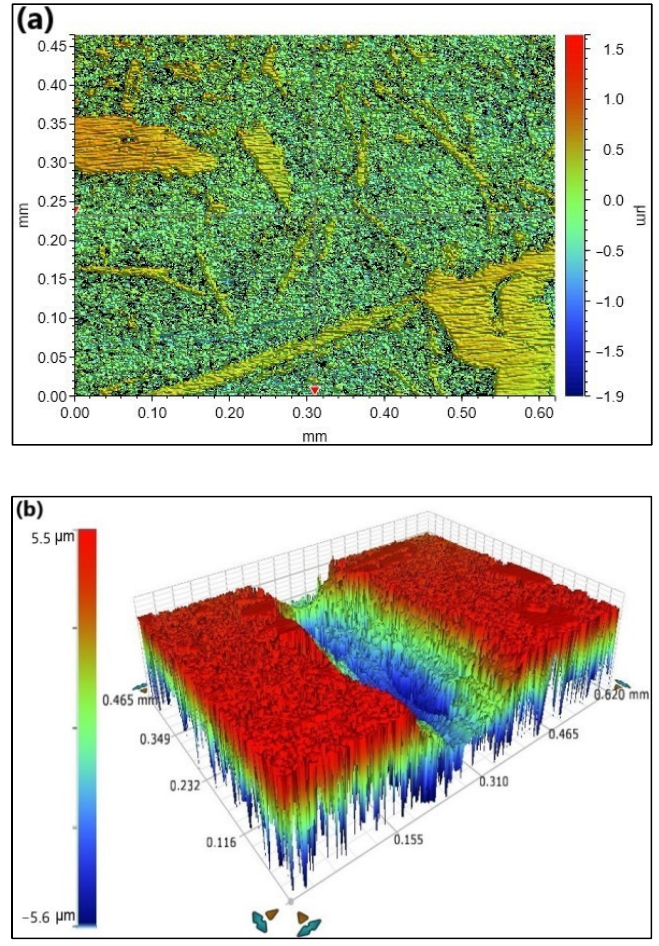
Figure 14. ( a ) The measured surface and ( b ) scratch of AlFeSi sample from the optical profiler.